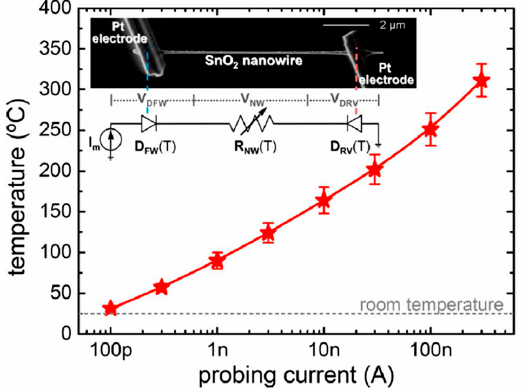
Figure 7. Estimated temperature of the devices at different I m . (r nw ~35 nm) (inset) SEM image of a SnO